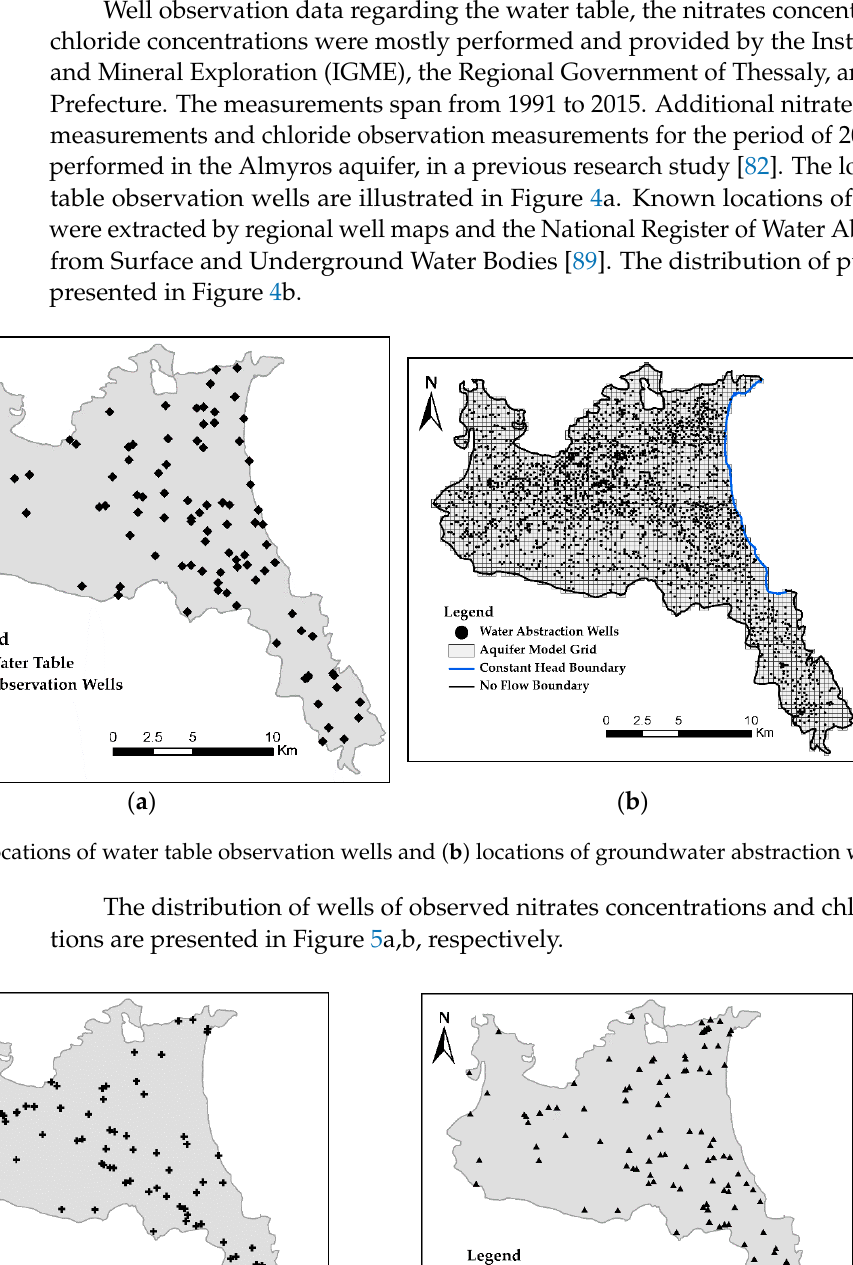
Figure 5. ( a ) Locations of nitrates observation wells and ( b ) locations of chlorides observation wells. 4. Results 4.1. Mean Areal Precipitation and Temperature The daily meteorological data of the station in N.Aghialos were aggregated to produce monthly time ‐ series of the variables of precipitation and temperature. The precipitation and temperature missing data of the surrounding stations were infilled using linear regression based on the N. Aghialos station, the only station in the region with no missing values. The coefficients and correlation of the stations used for the estimation of precipitation and temperature are shown in Tables 3 and 4.